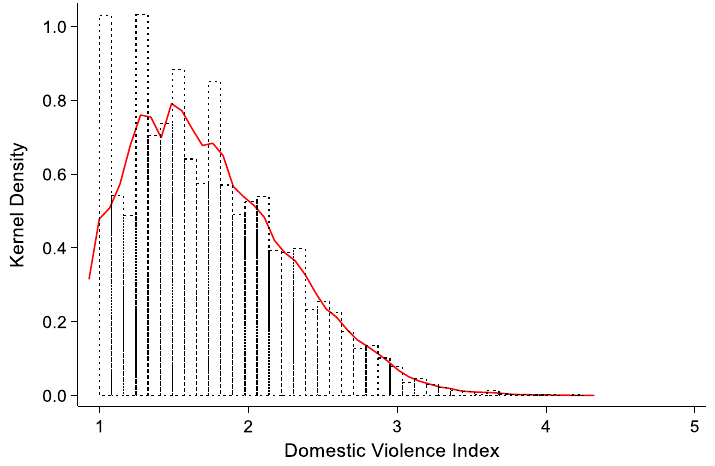
Figure 2. Nuclear density estimation of domestic violence index.